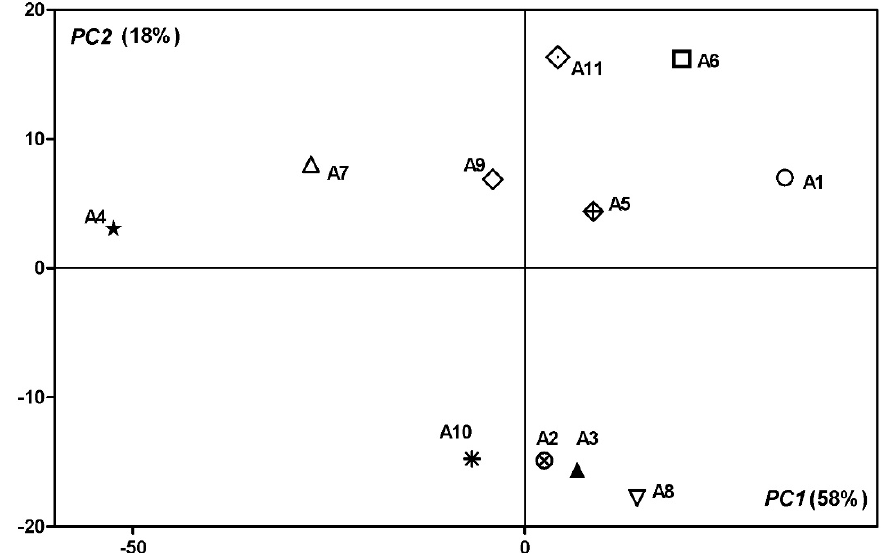
Figure 3. Principal components analysis bi-plots of 11 apricots cultivars based on their carotenoids content, fatty acids, and volatile profiles. The first two components together explain 76% of the data variation.